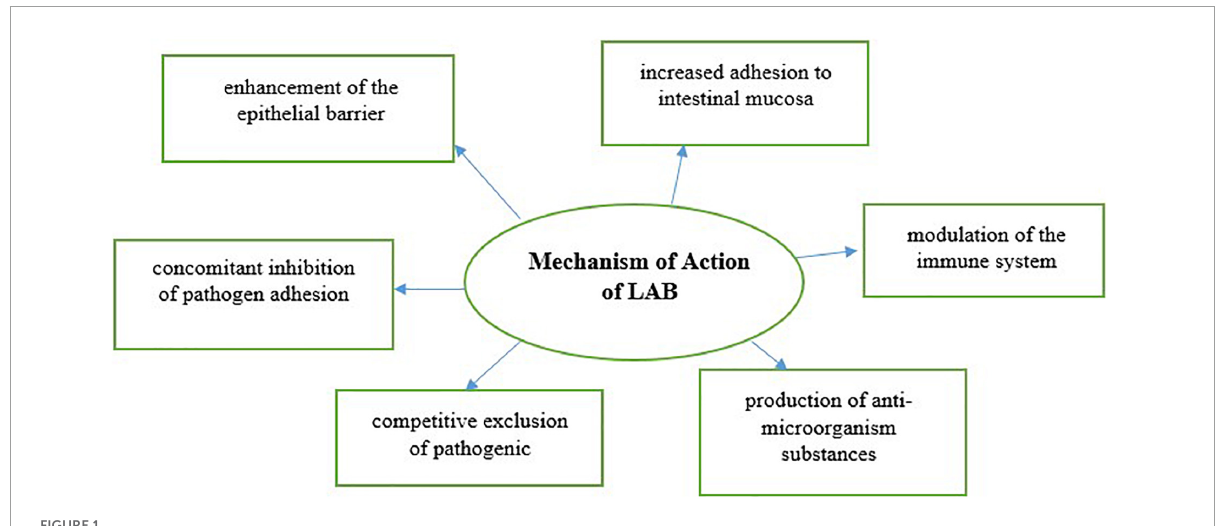
FIGURE1 Mechanism of action of lactic acid